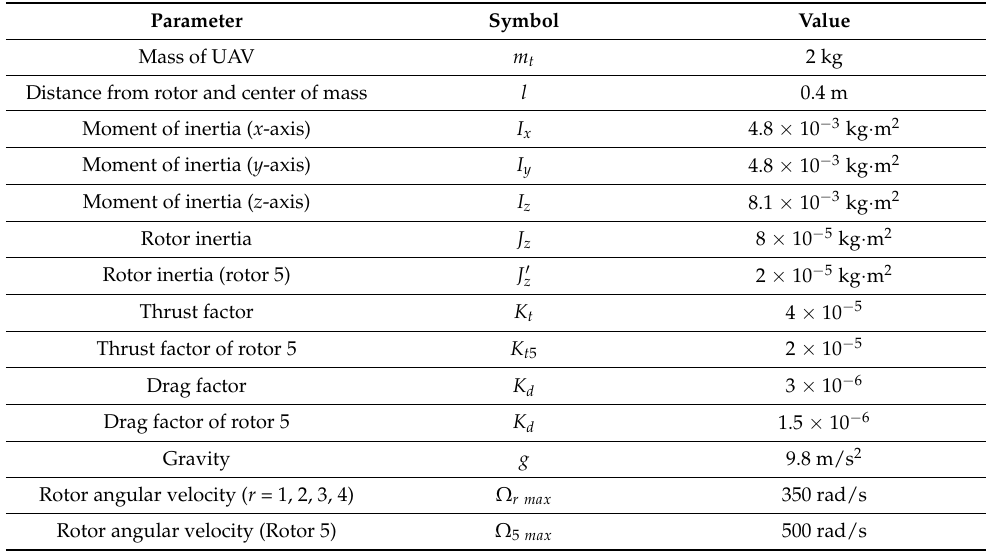
Table 1. The parameters of the modified UAV. Parameter Symbol Value Mass of